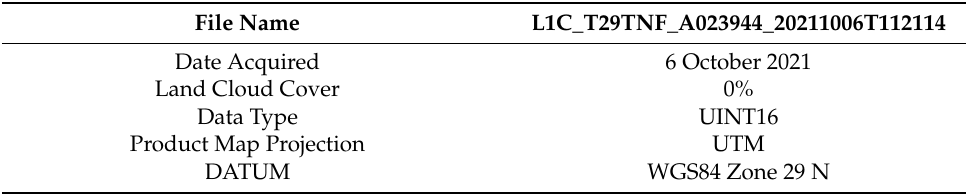
Table 2. Information about the downloaded Sentinel-2B data.